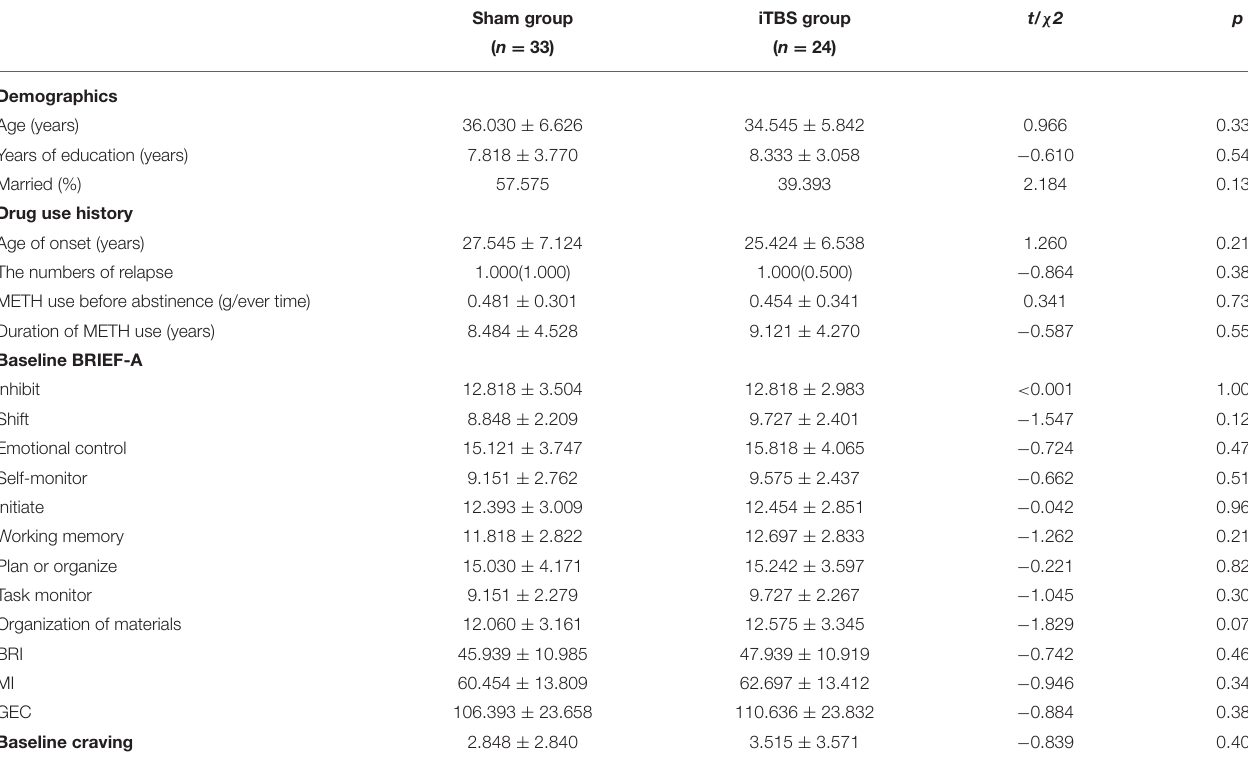
TABLE 3 | Demographics, drug use history, BRIEF-A, and VAS scores in two MUD groups before treatment had no difference. Sham group iTBS group t/ χ 2 p